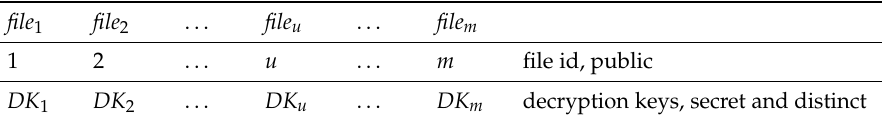
Table 3. Decryption keys for corresponding encrypted files.